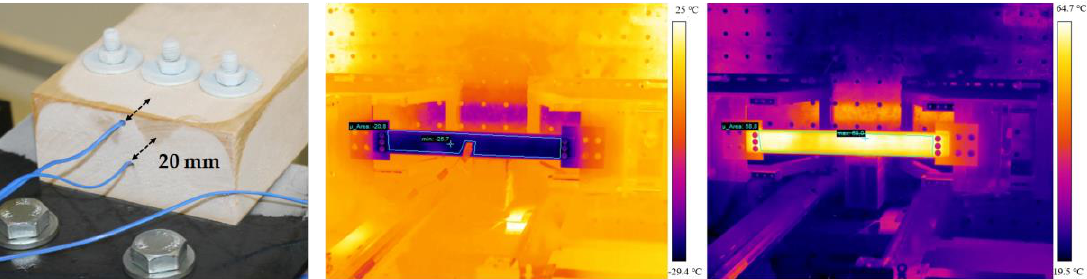
Figure 3. Position of the two temperature sensors in the end grain wood of the quasi-static tests ( a ) and exemplary images from the infrared camera for a − 30 ◦ C; ( b ) and a + 90 ◦ C; ( c )